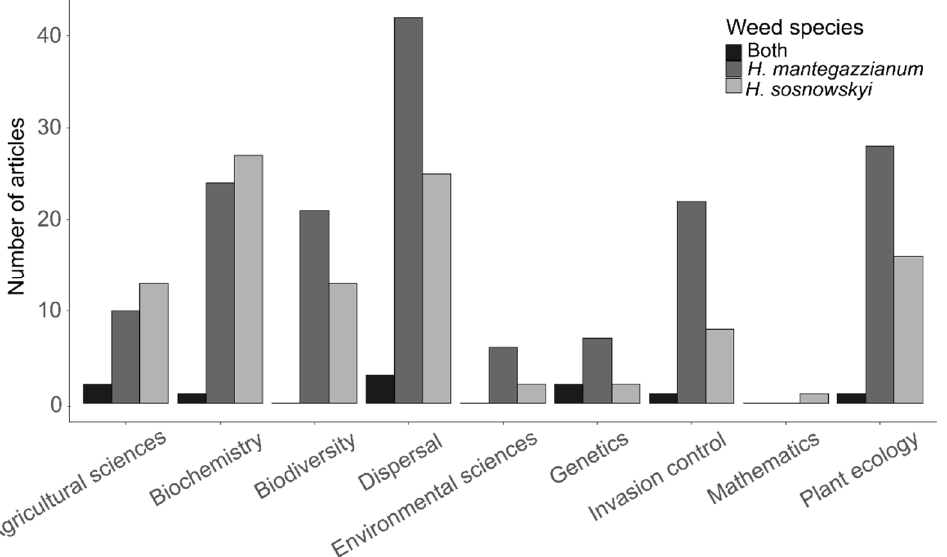
Figure 2. The number of articles included in this review concerning the two described Caucasian hogweeds distinguished into particular research areas. hogweeds distinguished into particular research